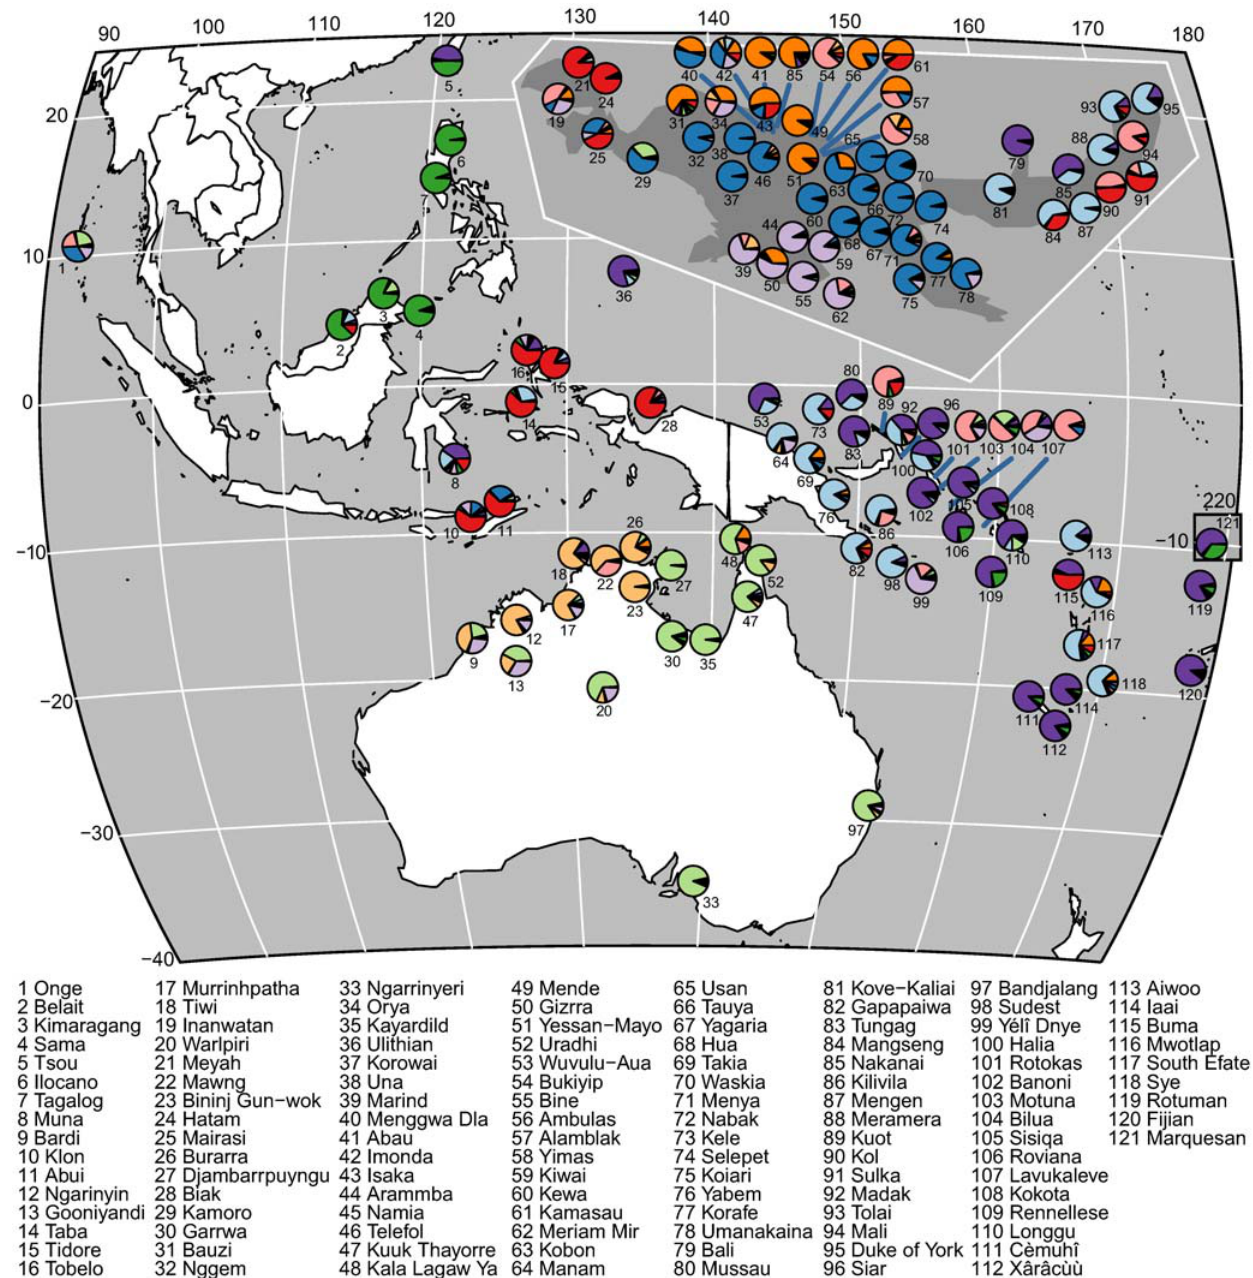
Figure 4. The geographic patterning of STRUCTURE results for K10. Recapitulating the K10 row from Figure 3.